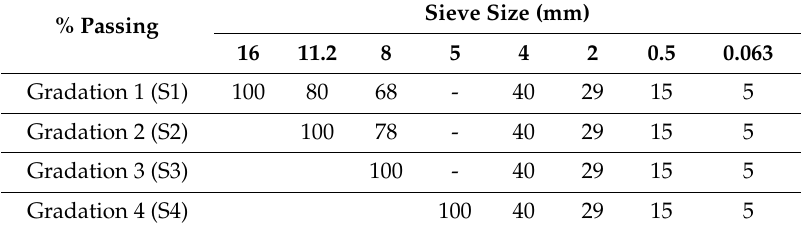
Table 2. Passing percentage for the designed aggregate gradations for stage 2.